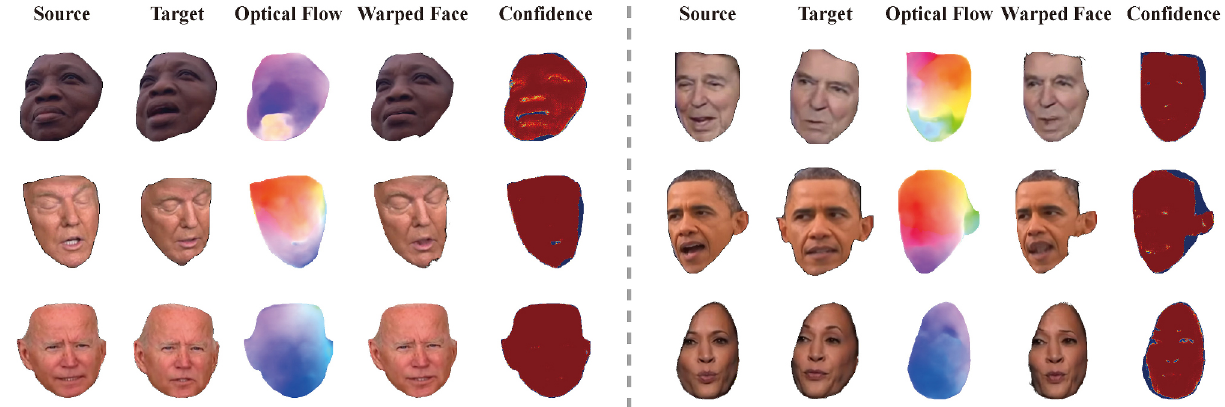
Fig. 8 Qualitative results using our method on real facial video